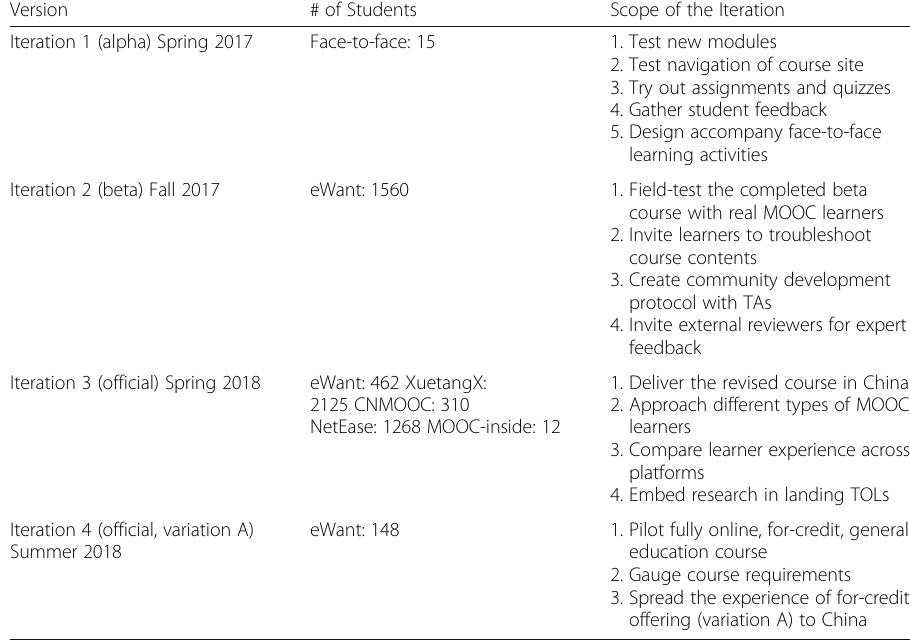
Table 2 Overview of the settings in the four iterations